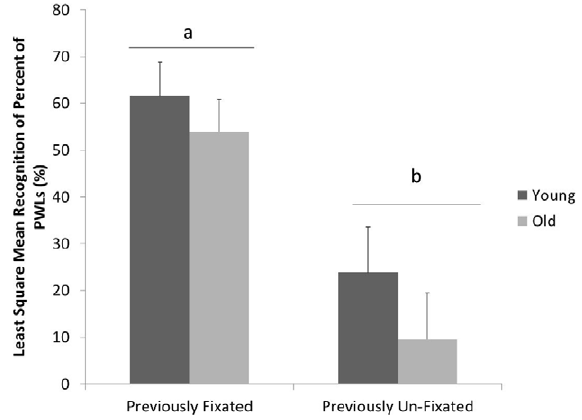
Figure 4. Estimated percentage of correctly recognized PWLs contingent on